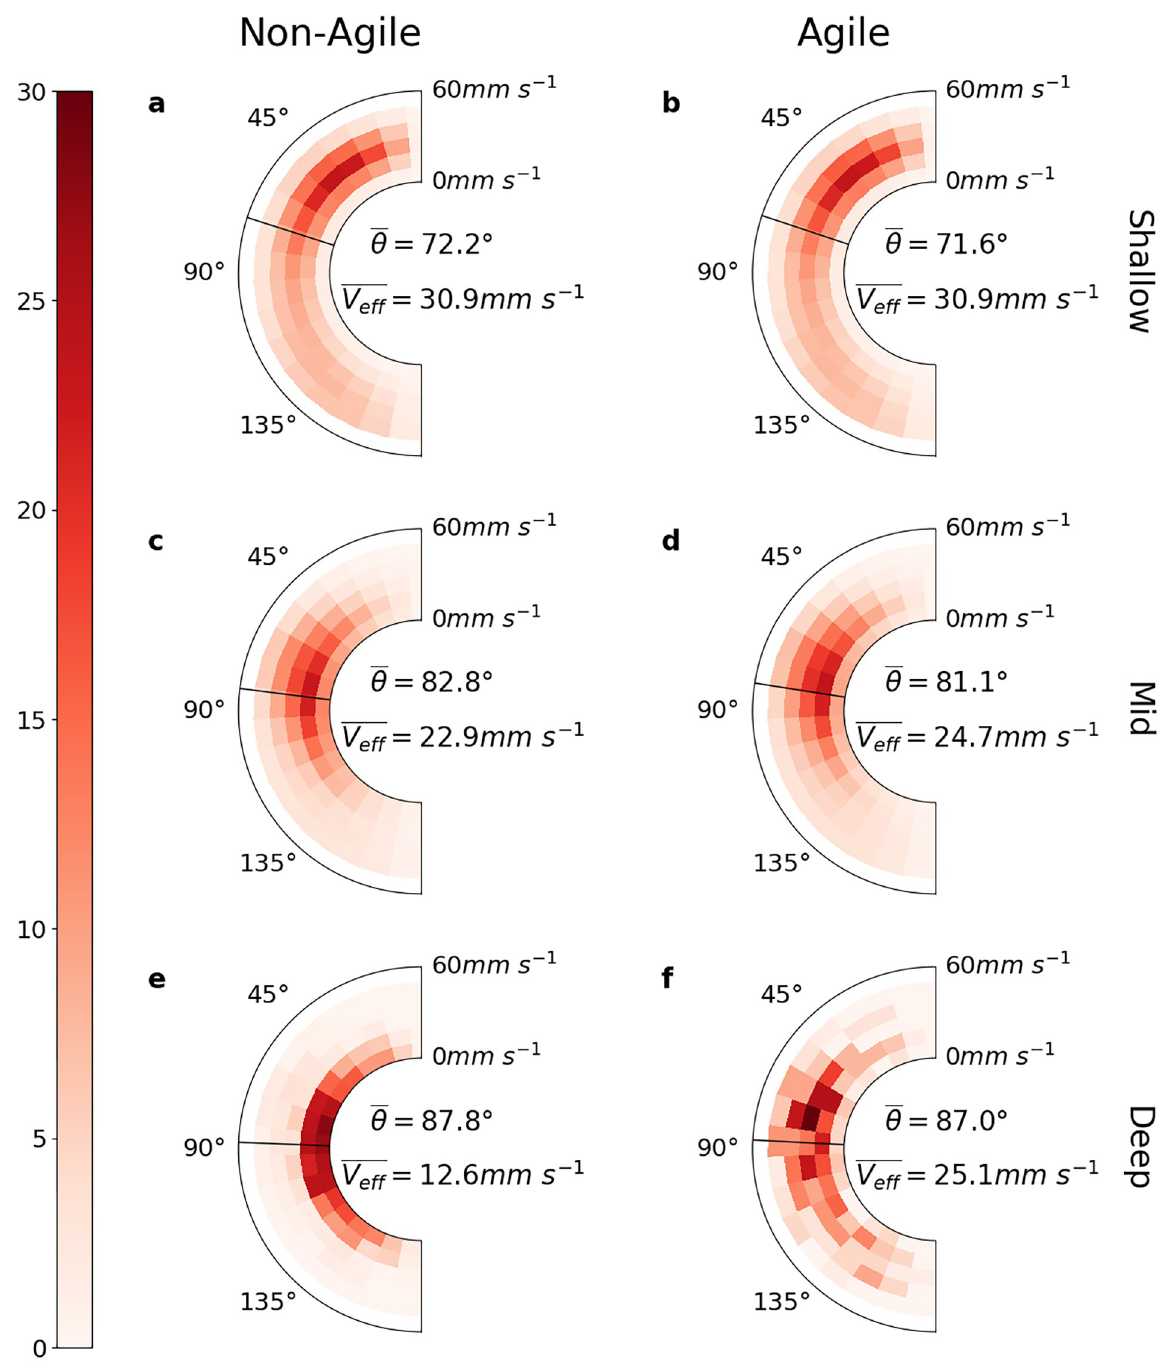
Fig 6. Normalised distributions of the magnitude and polar angle of effective velocity in each depth region of two simulations, respectively characteristic of non-agile (a, c, e) and agile (b, d, f) microbes. Microbes in the deep region had near-horizontal effective velocity, which acted to restrict their movement in the vertical direction. Also in the deep region, the difference in the magnitude of effective velocity (“effective speed”) was many times larger than the difference in microbial swimming speed. Elsewhere, effective speeds were very similar between all simulations, and the effective velocity was less vertically